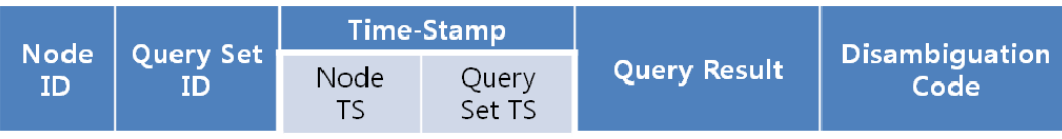
Figure 7. Response message payload format at the application